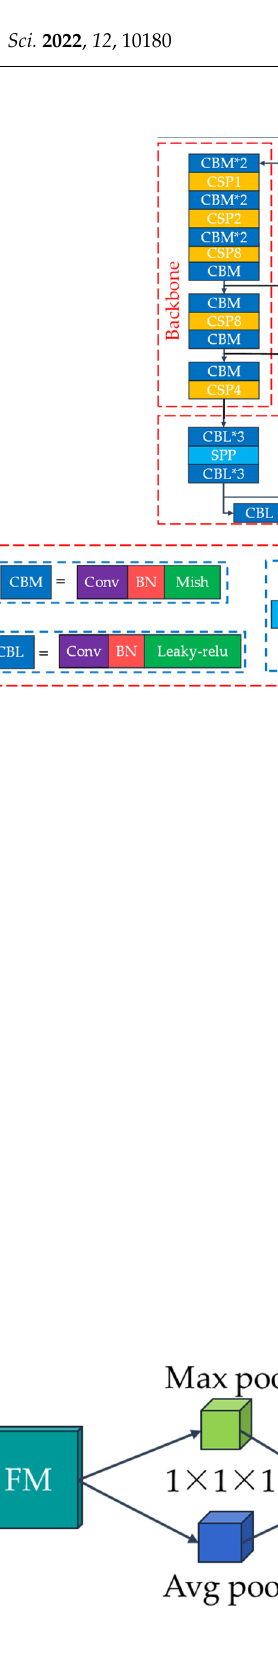
Figure 3. Flow of the channel attention module (when a feature map is used, the value of H × W × C is shown as 1 × 1 × 1).